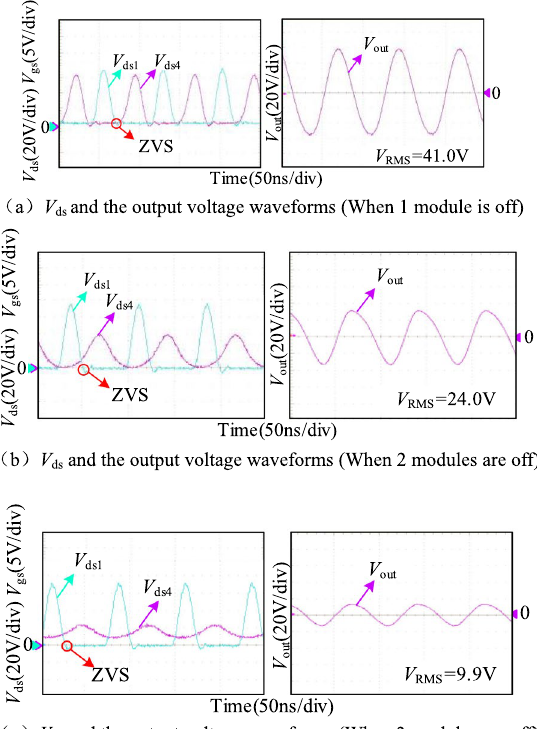
Fig. 12 System working waveforms under on–off control. a V ds and the output voltage waveforms (When 1 module is off) . b V ds and the output voltage waveforms (When 2 modules are off). c V ds and the output voltage waveforms (When 3 modules are off)